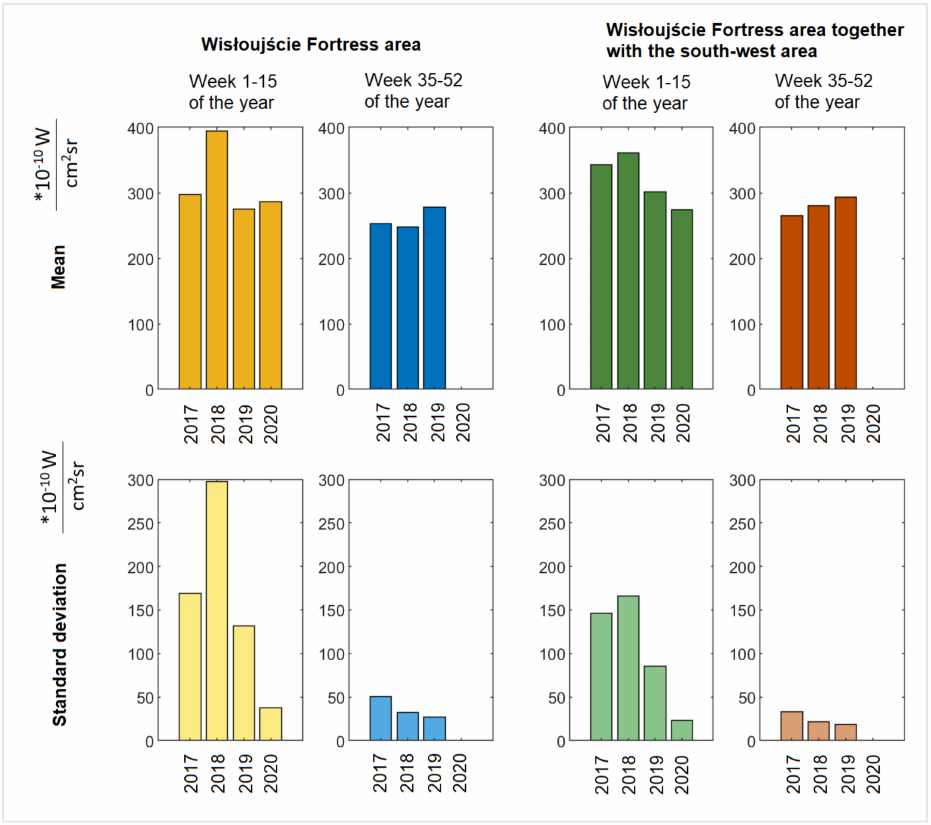
Figure 19. Average and standard deviation of the radiance analysed for the period between 2017 and 2020 for the areas concerned. Source: authors’ elaboration. * Unit of